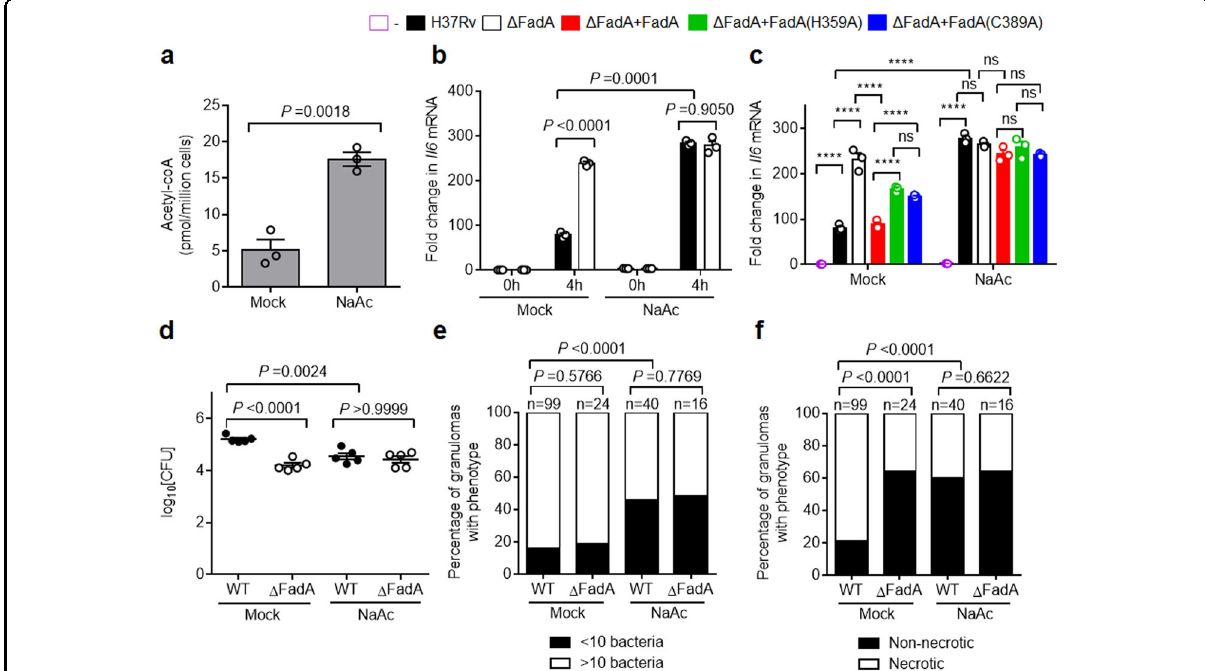
Fig. 7 Targeting acetyl-CoA alleviates pathogenesis of mycobacteria. a Acetyl-CoA level assay of peritoneal macrophages supplied with 2 mM NaAc for 24 h. b qPCR analysis of Il6 mRNA from control or 2 mM NaAc-supplemented peritoneal macrophages infected with H37Rv or H37Rv Δ FadA strains for 0 or 4 h (MOI = 1) (mean± SEM). c qPCR analysis of Il6 mRNA from control or 2 mM NaAc-supplemented peritoneal macrophages infected with H37Rv, H37Rv Δ FadA, H37Rv( Δ FadA + FadA), H37Rv( Δ FadA + FadA(H359A)), and H37Rv( Δ FadA + FadA(C389A)) strains for 4 h (MOI = 1)